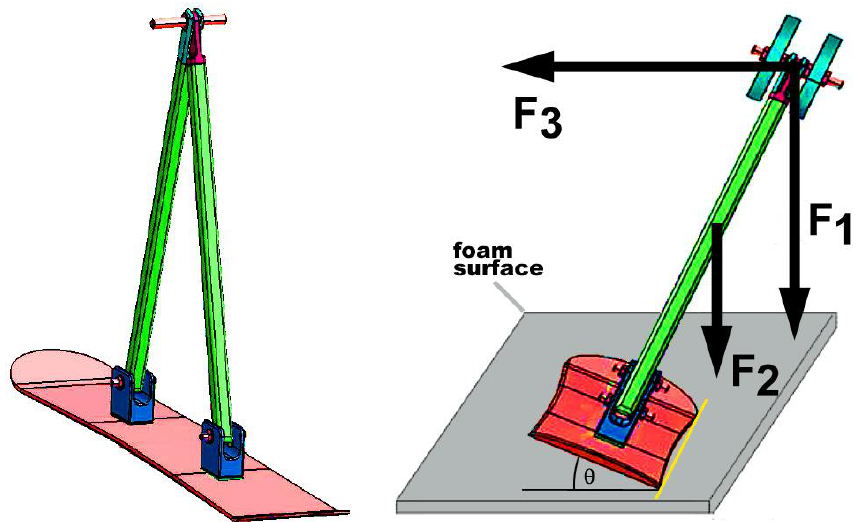
Figure 2. Test rig for tilting and loading the snowboard; F1 = gravitational force of a mass of 20 kg; F2 = gravitational force of the 11 kg frame; F3 = resulting belt force; θ = tilt angle of the board; yellow line = contact line between board and surface.